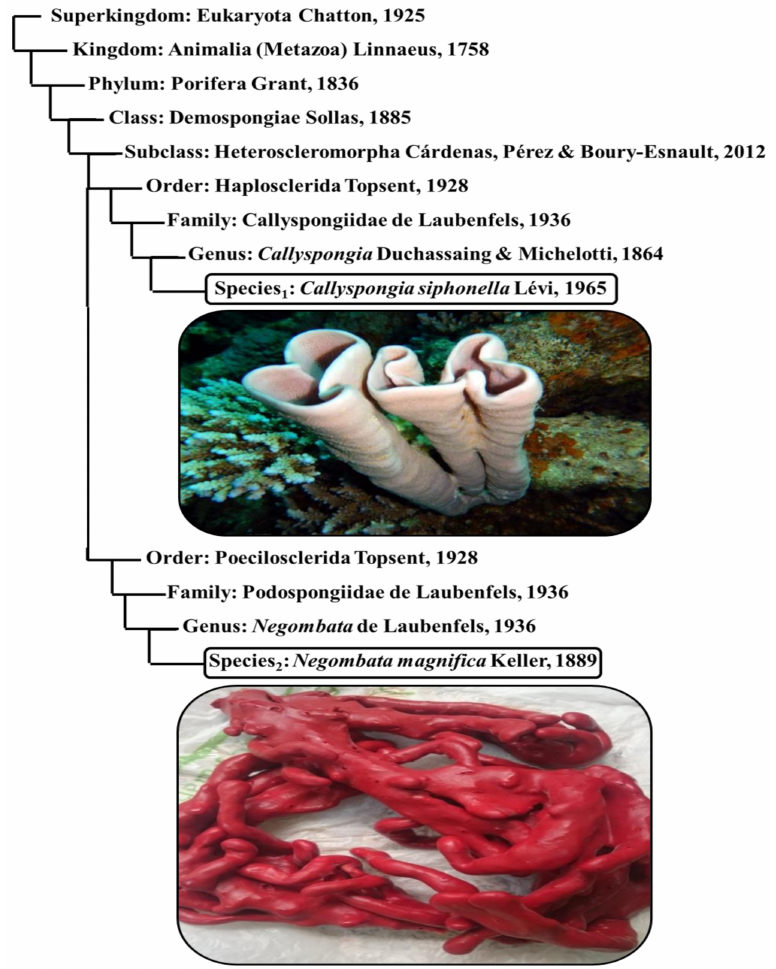
Figure 1. Taxonomical positions and photographs of Callyspongia siphonella and Negombata magnifica